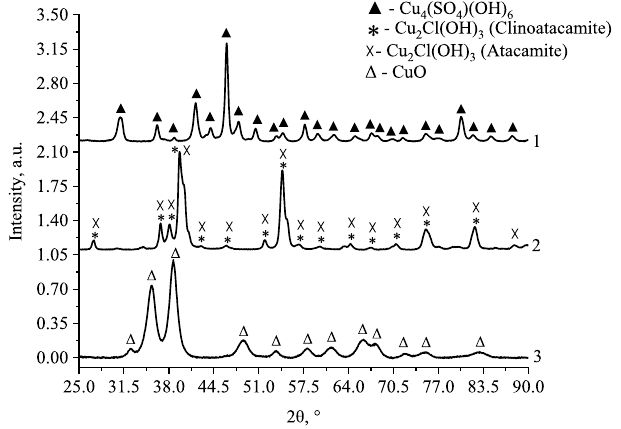
Figure 3. Diffraction patterns of samples, synthesized using copper (II) sulfate (1), copper (II) chloride (2), and copper (II) acetate